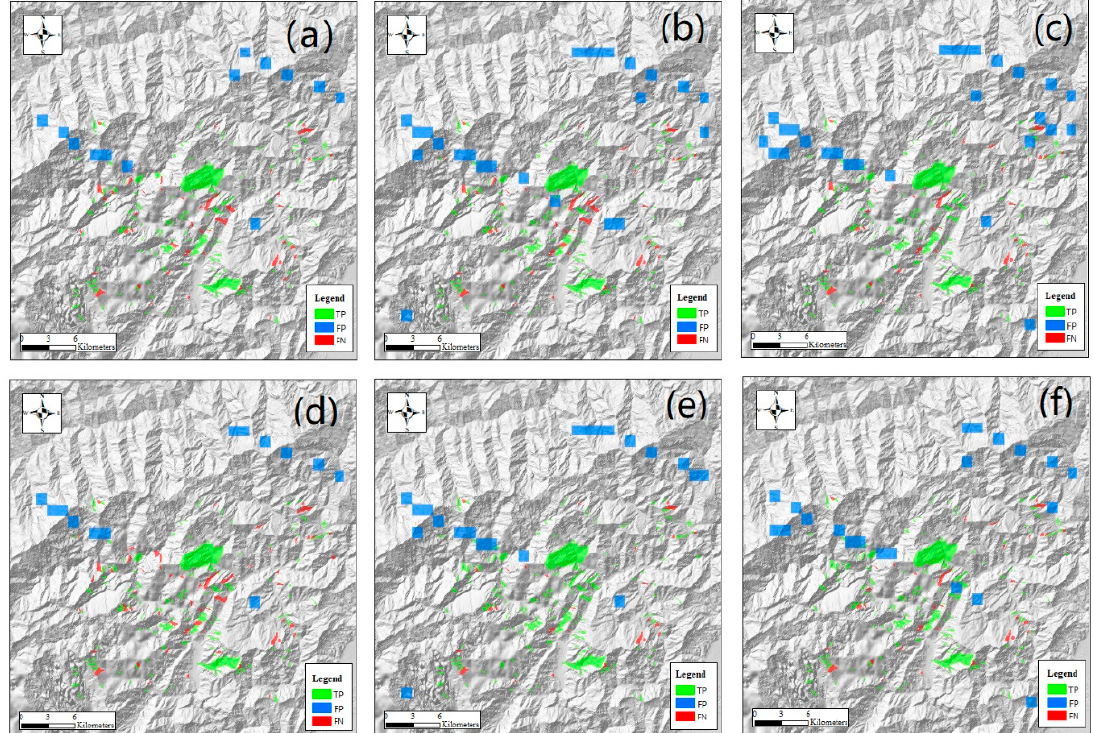
Figure 7. Detection results of scene-oriented models with sample set S10000 around the Daguangbao landslide (the central one) in the Wenchuan earthquake area: ( a ) VGG16; ( b ) ResNet50; ( c ) DenseNet120; ( d ) VGG19; ( e ) ResNet101; ( f ) DenseNet201. The Daguangbao landslide is known for its area (7.11 km 2 ) and height difference (1567 m) [46]. Here, landslides correctly detected ( TP ) or missed ( FN ) are shown in the form of polygons, while scenes misidentified as landslides ( FP ) are shown in blue rectangles. The blurred patch in the southwest is a defect of the original DEM, not related to the detection result.